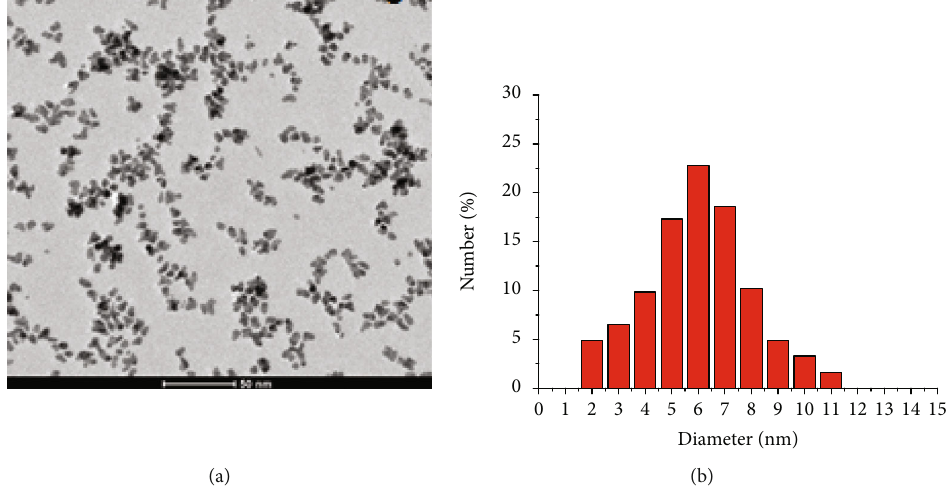
Figure 1: ТЕМ image of AuNPs in Polymer/AuNP nanosystem (a) and size distribution histogram of AuNPs in this sample (b).